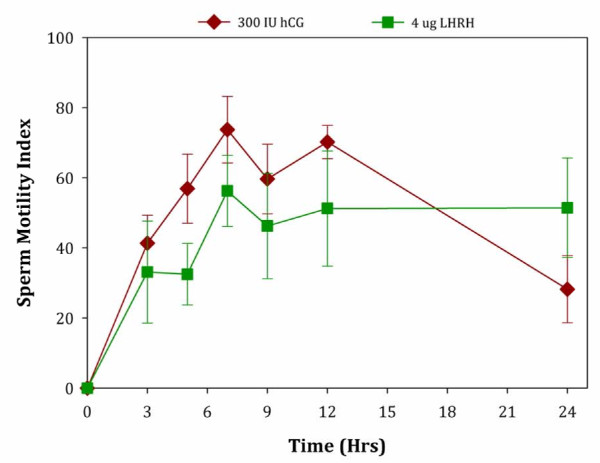
A comparison of the sperm motility index (SMI) for Anaxyrus americanus treated with either 300 IU hCG (diamonds) or 4 μg LHRH (squares). Data are expressed as Mean ± SEM. For number of animals comprising each treatment Mean see Figure 1.